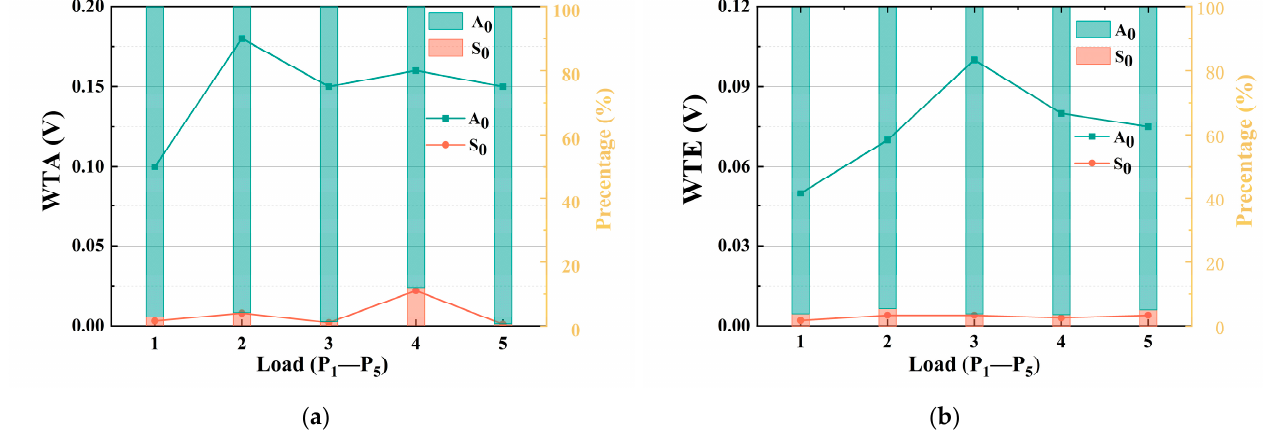
Figure 9. Comparison of MAE characteristic parameters between WTA ( a ) and WTE ( b